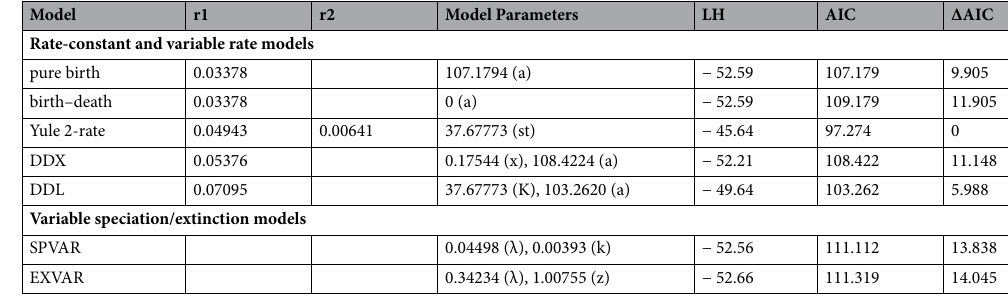
Table 5. Statistical output of models tested in diversification analysis of Asian forest scorpions (Scorpionidae: Heterometrinae): extinction fraction (a), carrying capacity (K), speciation rate change (k), magnitude of rate- change (x), extinction rate change (z), speciation rate